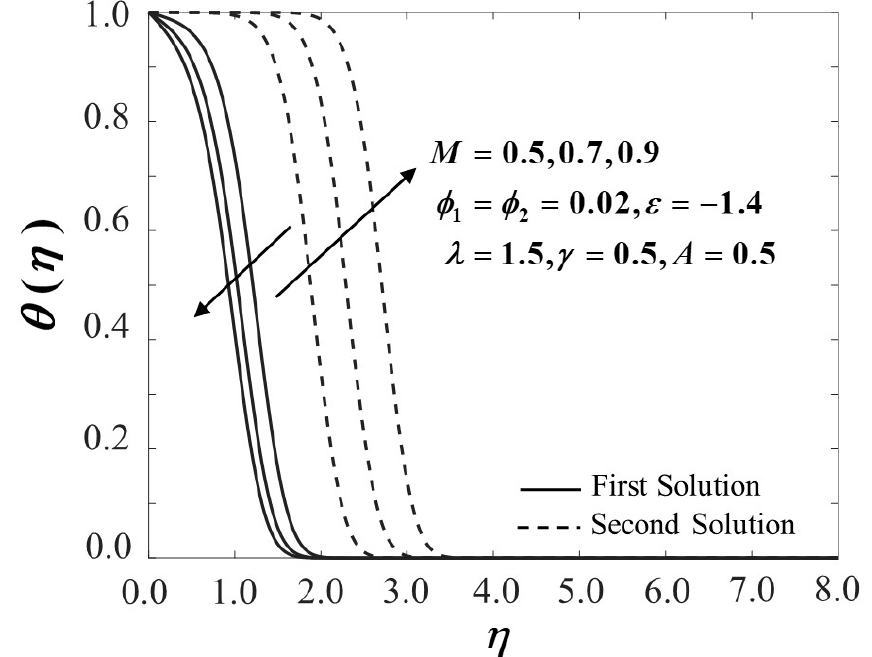
Figure 15. Temperature profiles of θ ( η ) for di ff erent values of M .